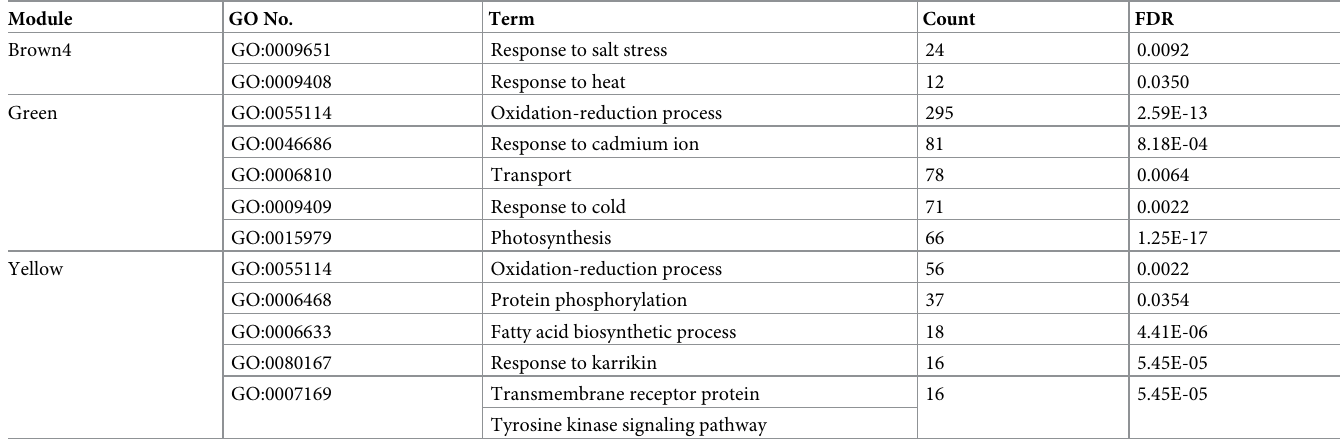
Table 2. GO enrichment analysis of genes in the selected